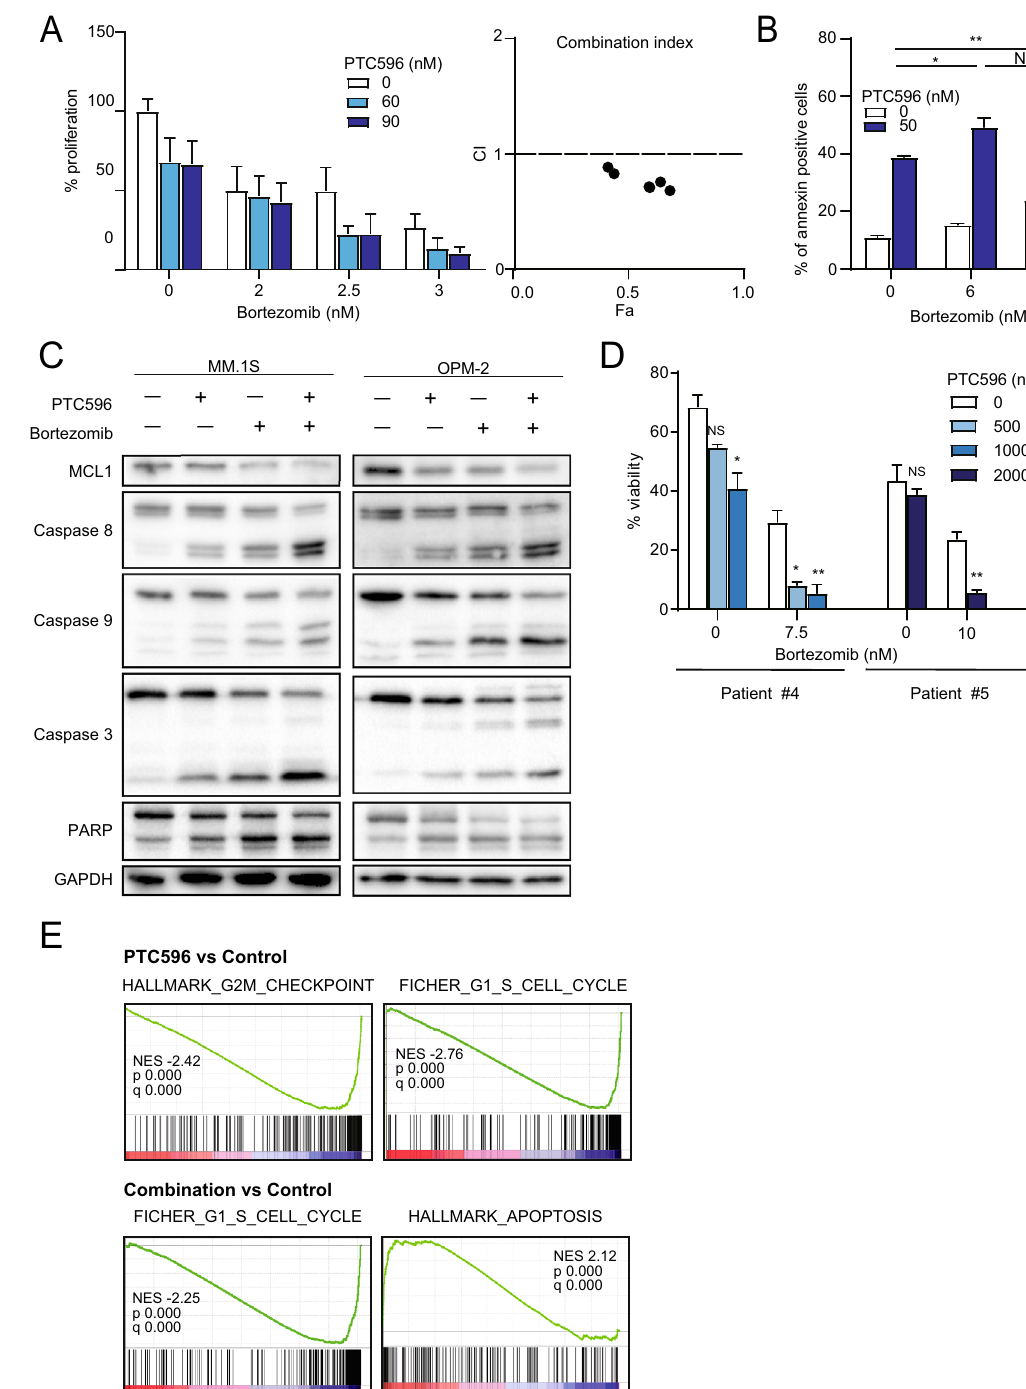
Figure 3. PTC596 enhances bortezomib-induced apoptosis. ( A ) BrdU proliferation assay of MM.1S co-cultured with BMSCs derived from patients with MM upon treatment with the indicated doses of PTC596 and bortezomib for 48 h. Results of triplicate experiments and combination index values are shown in the left and right graphs, respectively. ( B ) Annexin V staining of OPM-2 treated with the indicated doses of PTC596 for 48 h and bortezomib for 24 h. Apoptotic cells were detected as Annexin V-positive cells by flow cytometry, and the results of duplicate experiments are shown. Data represent mean ± SD. * P < 0.05; ** P < 0.01; ns, not significant using one-way ANOVA. ( C ) Western blotting analysis of the indicated proteins in MM.1S and OPM-2. MM.1S and OPM-2 were treated with PTC596 (100 nM) and/or bortezomib (2 nM for MM.1S and 5 nM for OPM-2) for 48 h. GAPDH served as a loading control. ( D ) The cytotoxicity of the combination treatment of PTC596 and bortezomib against primary MM cells. Viable cells were defined as those negative for Annexin V and PI by flow cytometric analyses. Primary MM cells were treated with the indicated doses of PTC596 and/or bortezomib for 12 or 24 h. Data represent mean ± SD. * P < 0.05; ** P < 0.01; n.s., not significant using Student’s t -test or one-way ANOVA. ( E ) Gene set enrichment analysis plots showing the enrichment of cell cycle or apoptosis gene sets in MM.1S treated with PTC596 alone (left panels) and the combination (right panels) compared with non-treated control cells. MM.1S cells were treated with PTC596 (100 nM) alone or in combination with bortezomib (2 nM) for 24 h. Total RNA was extracted and RNA-seq was performed. Normalized enrichment scores (NES), nominal p values (NOM), and false discovery rates (FDR) are